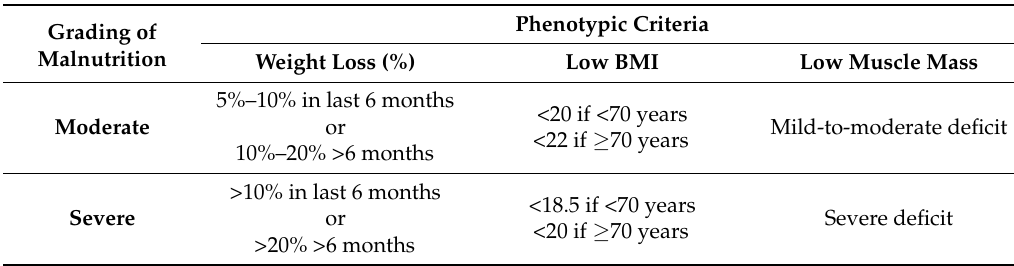
Global Leadership Initiative on Malnutrition guidance on grading of severity of malnutrition [32]. BMI = body mass